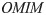
The Cross Domain Query Graphs for Topic 16 and Topic 27.In the cross domain query graph, the circle represents a concept and the triangle represents a predicate. A color is assigned to each domain as follows: DrugBank: Red; HGNC: Pink; MGI: Green; PharmGKB: Cyan; ClinicalTrials: Yellow; OMIM: Sky Blue; SIDER: Gray; KEGG: Orange; CTD: Magenta. The cross domain query graph is composed with the paths between Topic 27 and Topic 16 such as i) {dv:Drug (SIO_010038) → dv:target → dv:Target(SIO_010423) → dv:x-genecards → dv:Gene(SIO_001121)}; ii){DrugBank:〈dv:Drug (SIO_010038) → dv:target → dv:Target(SIO_010423) → dv:x-uniprot〉 ⇒ OMIM:omimv:Uniprot}; iii) {omimv:Resource → omimv:x-uniprot → omimv:Uniprot}.